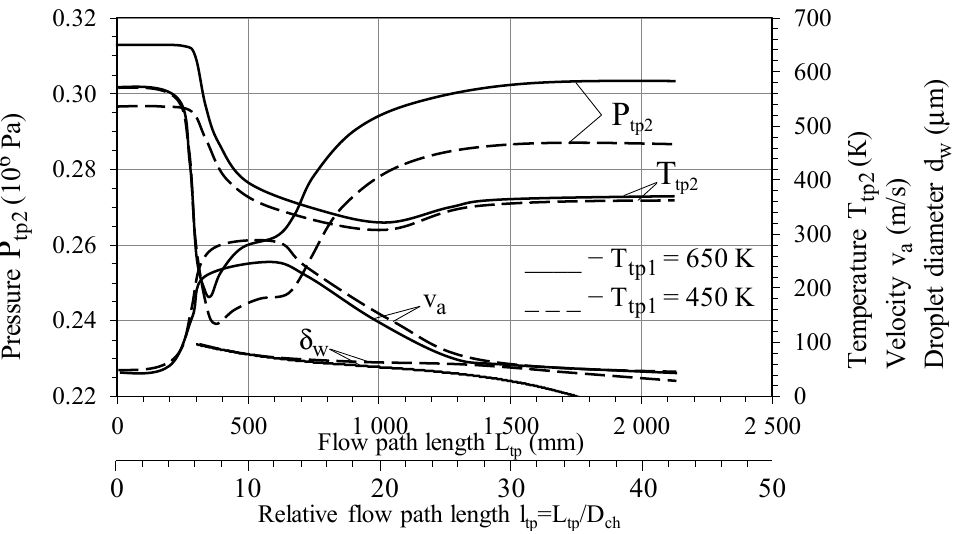
Figure 10. Dependences of changes in pressure, P tp2 ; air temperature, T tp2 ; air velocity, v a ; and droplet diameter, δ w , along the length of the thermopressor flow path, L tp (l tp ). It should be noted that, with an initial droplet diameter of more than 20–30 microns, the achievement of a positive effect from thermo-gas-dynamic compression is possible